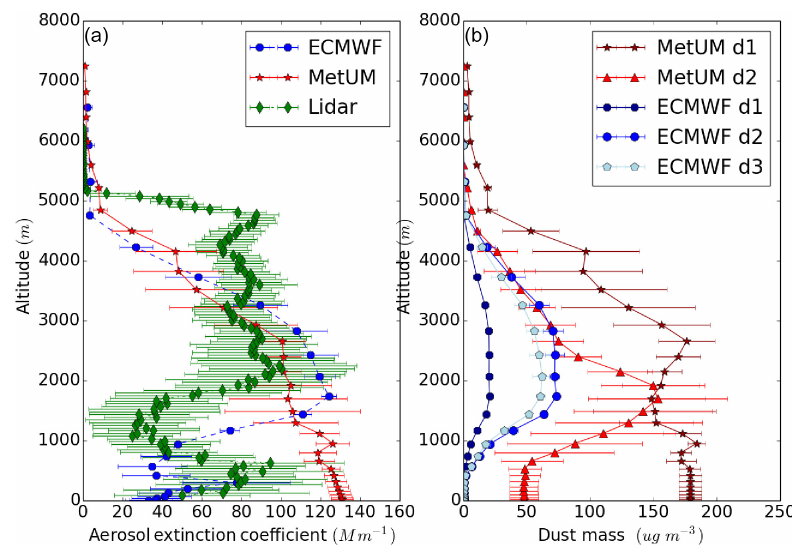
Figure 4. Case study 1, B920, 7 August, R6: (a) mean and standard deviation of the airborne lidar (green), MetUM (red), and ECMWF (blue) extinction profiles. (b) Modelled MetUM dust concentration for divisions 1 (dark red) and 2 (red), as well as modelled ECMWF concentration for divisions 1 (dark blue), 2 (blue), and 3 (light blue) dust. See text for the description of the divisions.